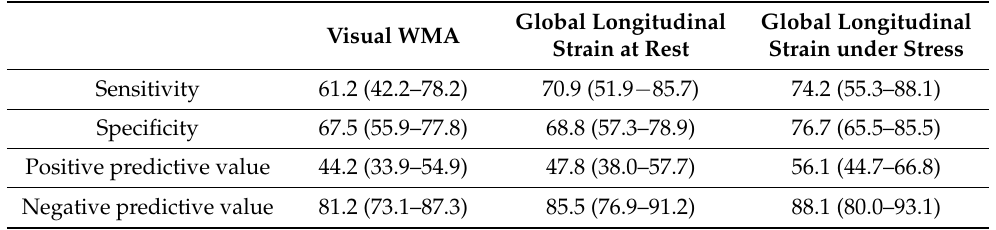
Figure 6. Receiver operating curve for sensitivity and specificity of GLS (global longitudinal strain) at rest and under dobutamine stress in detecting significant coronary artery disease. Table 2. Sensitivity, specificity, positive predictive value, and negative predictive value of visual wall motion abnormalities (WMA) under stress and strain parameters at rest and under stress in detecting CAD. Values in %, 95% CI.